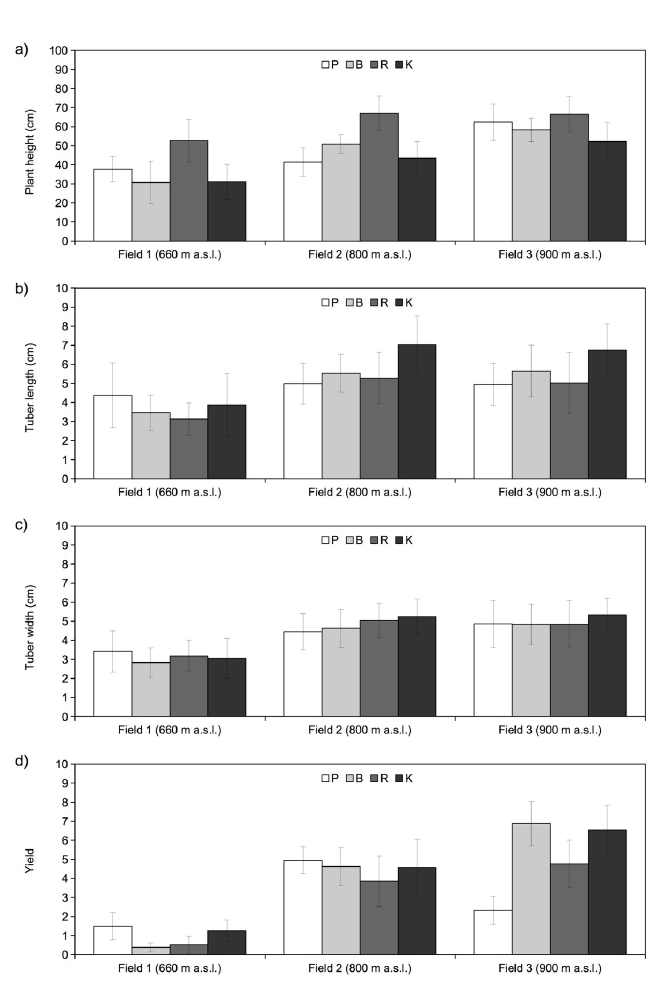
Fig. 5: Biological and agronomic features of the four potato genotypes (P, Prugnona; B, Bianca; R, Rubra Spes; K, Kennebec) cultivated in the three experimental